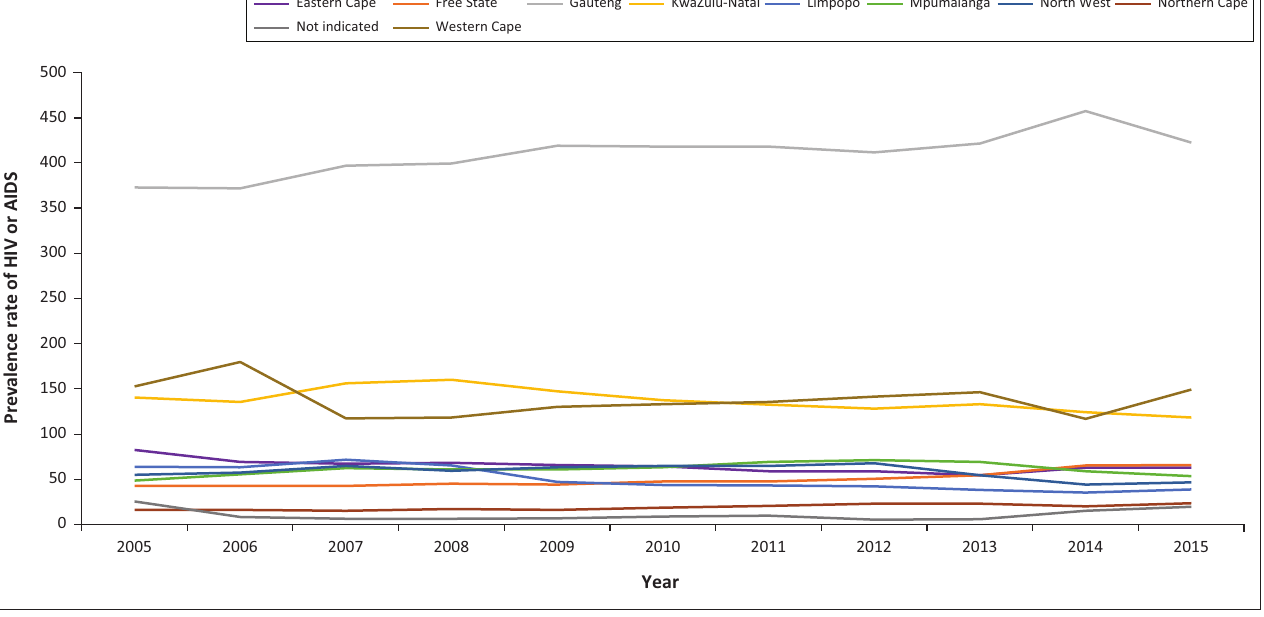
HIV or AIDS, human immunodeficiency virus or acquired immunodeficiency syndrome. FIGURE 5: Prevalence rate of human immunodeficiency virus or acquired immunodeficiency syndrome patients per 1000 medical scheme beneficiaries in different provinces of South Africa from 2005 to